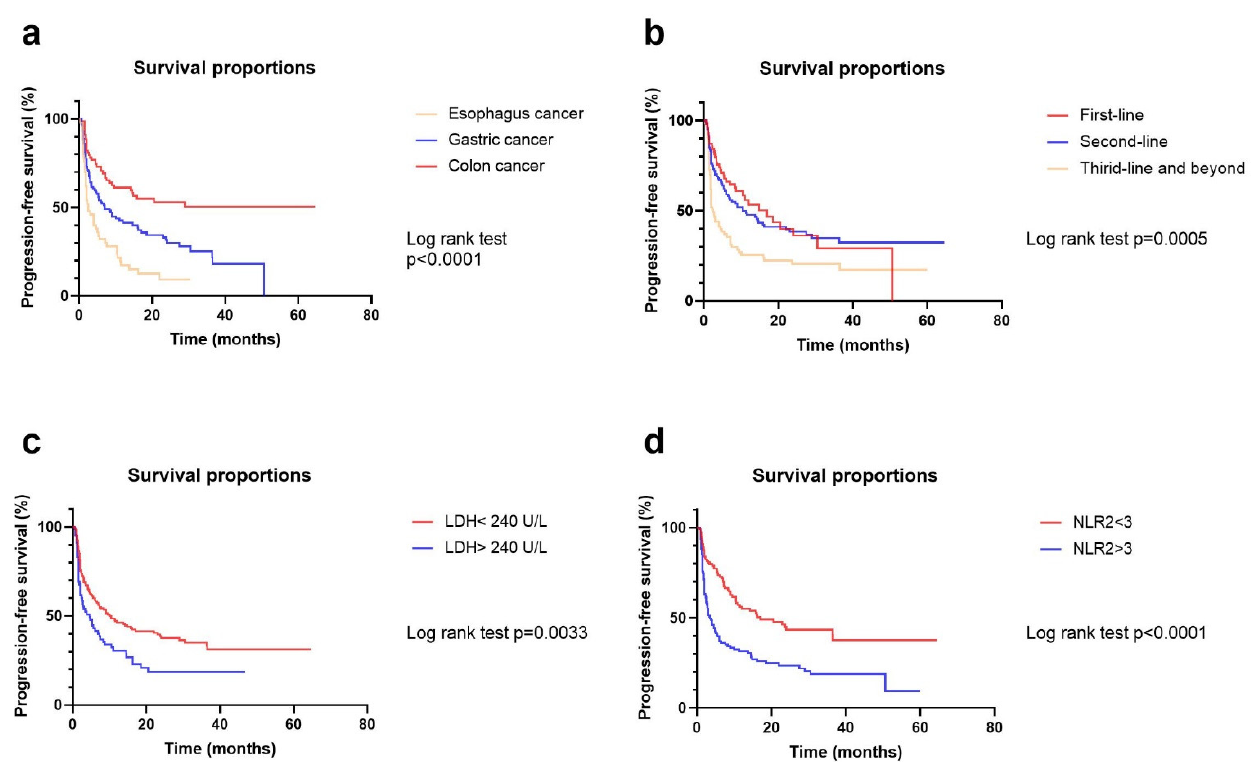
Figure 1. Survival curves according to tumor types ( a ), treatment lines ( b ), LDH ( c ), and NLR2 ( d ). Log-rank tests were used to evaluate survival differences.